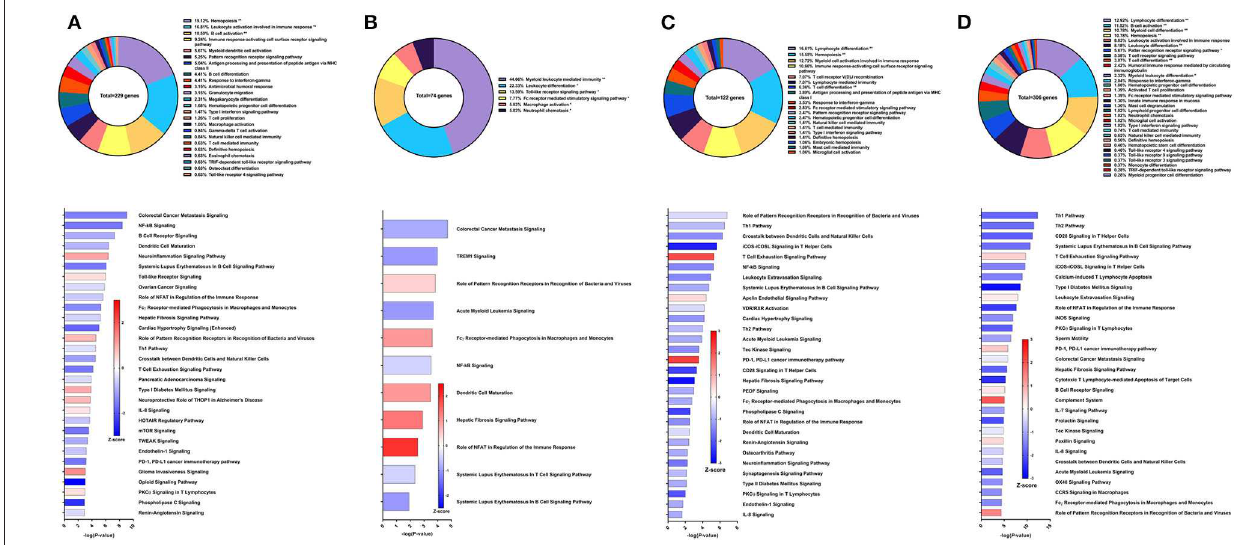
FIGURE 9 | RNA-Seq analysis of rSm-p80 + GLA-SE, a recombinant protein vaccine strategy. (A) PBMCs after vaccination (Top) Gene ontology enrichment analysis represented as a pie graph of percentages of genes per group out of a total number of differentially expressed genes. “**” and “*” indicates P < 0.05 and P < 0.01, respectively. (Bottom) Canonical pathway analysis generated using IPA. Bars are plotted based on the – log10( P -value) and colored based on predicted activation (red) and deactivation/inhibition (blue) according to the Z-score, a composite assessment based on the degree of overlap between directional expression of genes from the observed data and the Qiagen-curated public database. The top 30 pathways are shown based on the lowest P -values. (B) PBMCs after challenge (Top) Gene ontology enrichment analysis. (Bottom) Canonical pathway analysis generated using IPA. (C) Spleen cells (Top) Gene ontology enrichment analysis. (Bottom) Canonical pathway analysis generated using IPA. (D) Mesenteric lymph node cells (Top) Gene ontology enrichment analysis. (Bottom) Canonical pathway analysis generated using